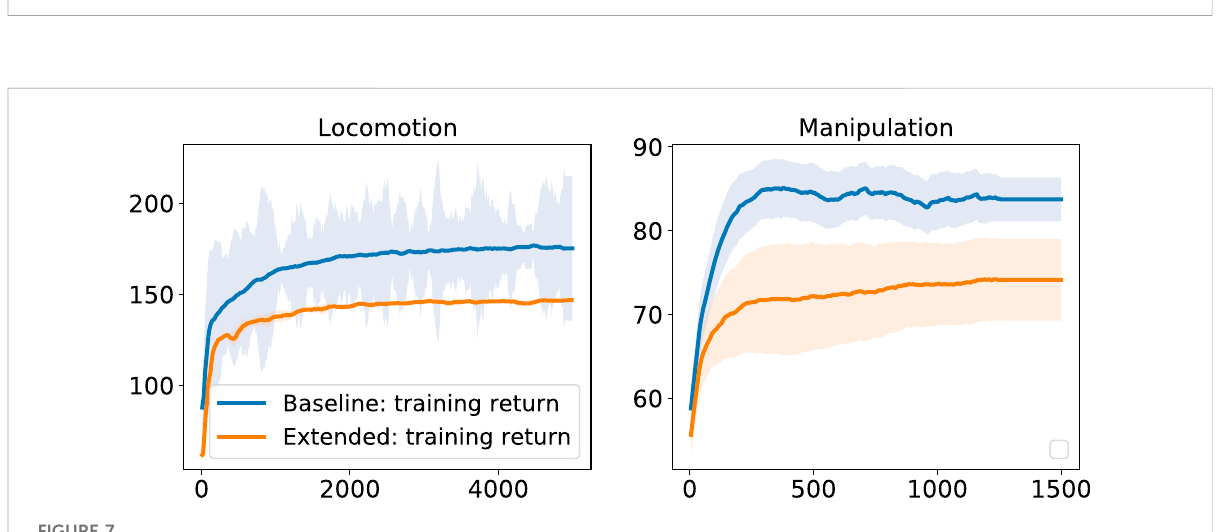
FIGURE 7 Performance for different state space con fi gurations for locomotion (left) and manipulation